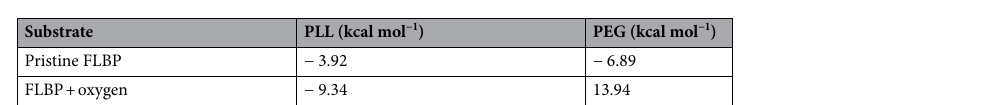
Table 1. Results of simulation of adsorption energy for pristine FLBP and oxidised FLBP with PLL and PEG as linkers.